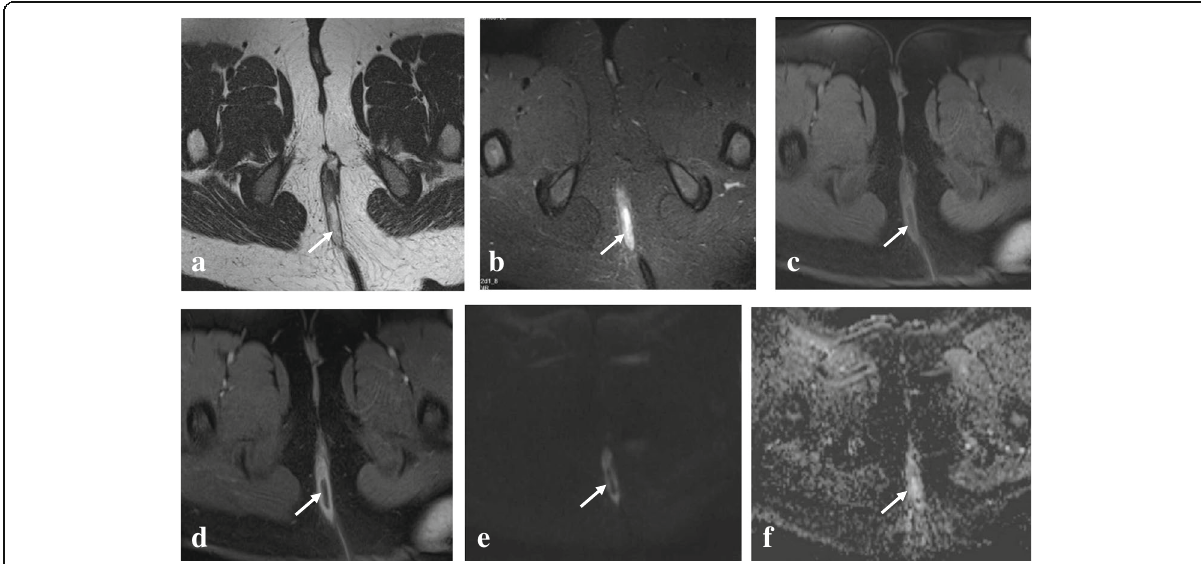
Fig. 7 A 17-year-old boy with perineal abscess seen at 6 o ’ clock of the anal canal opens through an inter-sphincteric sinus tract to the anus. a Axial T2-weighted image shows a perineal abscess (arrow) that exhibits high signal intensity. b Axial STIR-weighted image reveals high signal intensity of the perineal abscess (arrow). c Axial T1 fat-saturated weighted image reveals intermediate signal intensity of the perineal abscess (arrow). d Axial T1 fat-saturated post-contrast injection weighted image reveals contrast enhancement of the perineal abscess walls (arrow). e